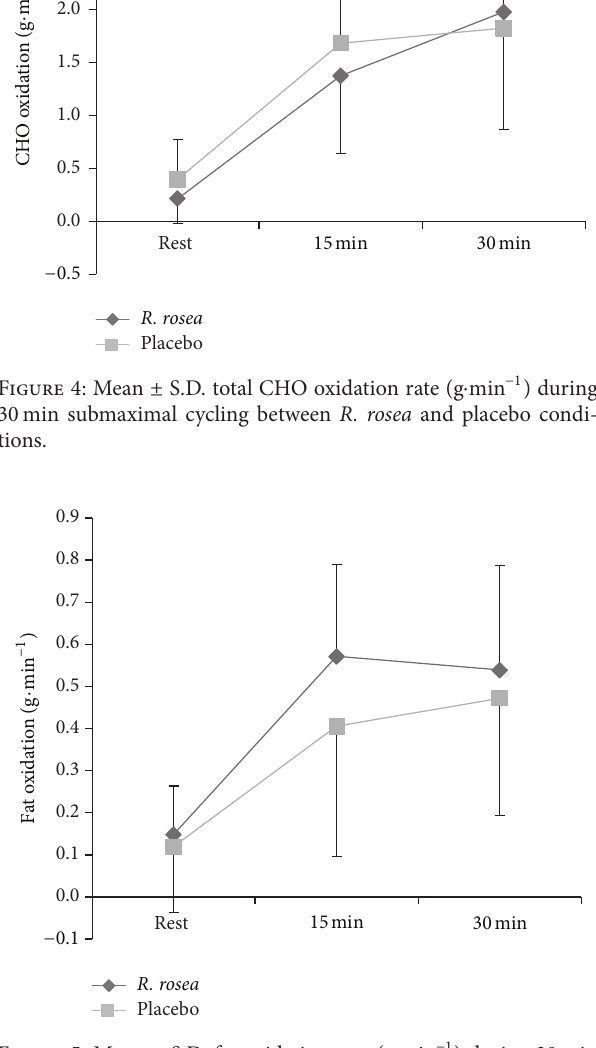
Figure 5: Mean ± S.D. fat oxidation rate (g ⋅ min −1 ) during 30 min submaximal cycling between R. rosea and placebo